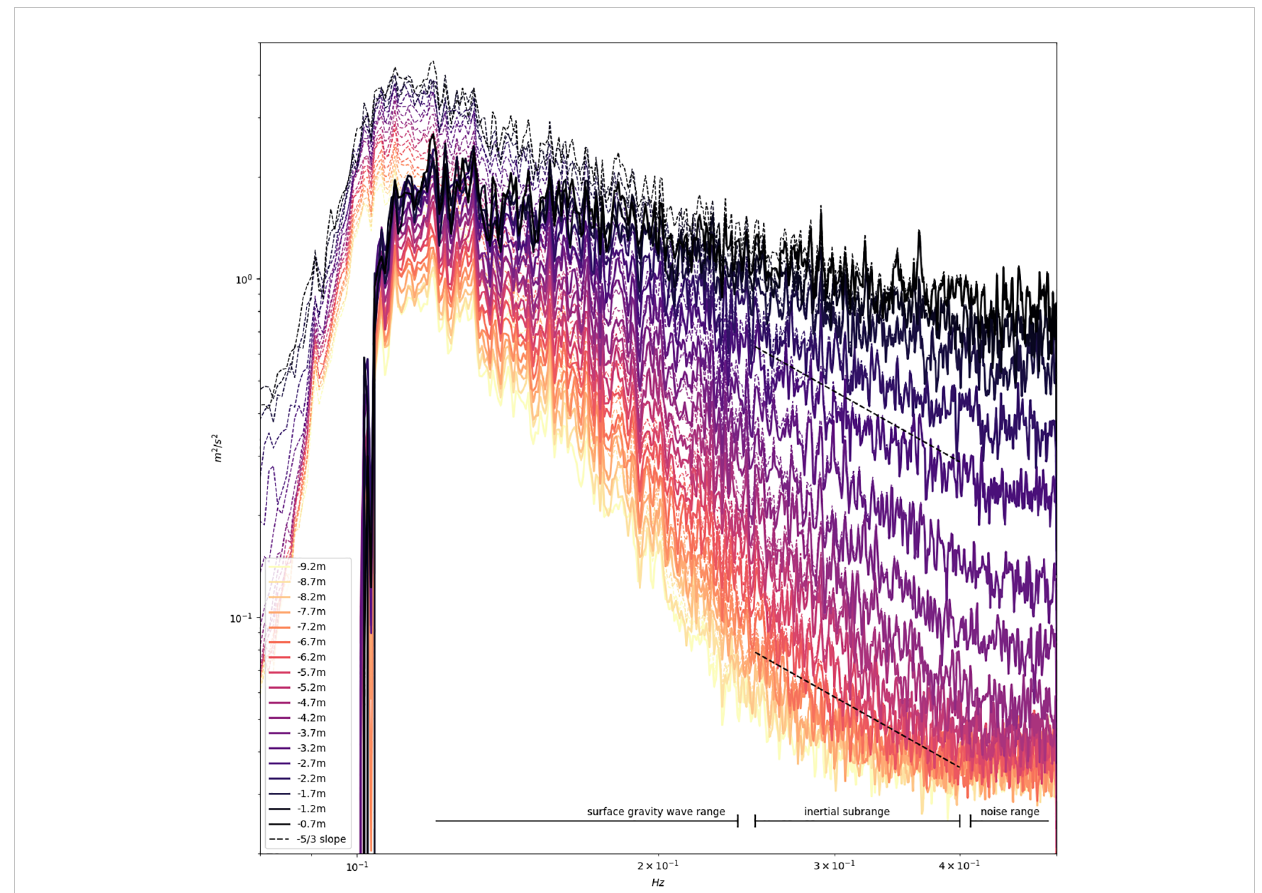
FIGURE 4 Variance spectra of vertical velocities obtained from ADCP measurements sampling at 1 Hz, for various depths below the ocean surface. The dashed lines show energy spectra obtained directly from ADCP currents. Solid lines show energy spectra where the surface gravity wave spectra is subtracted as inferred from the pressure signal at the ADCP